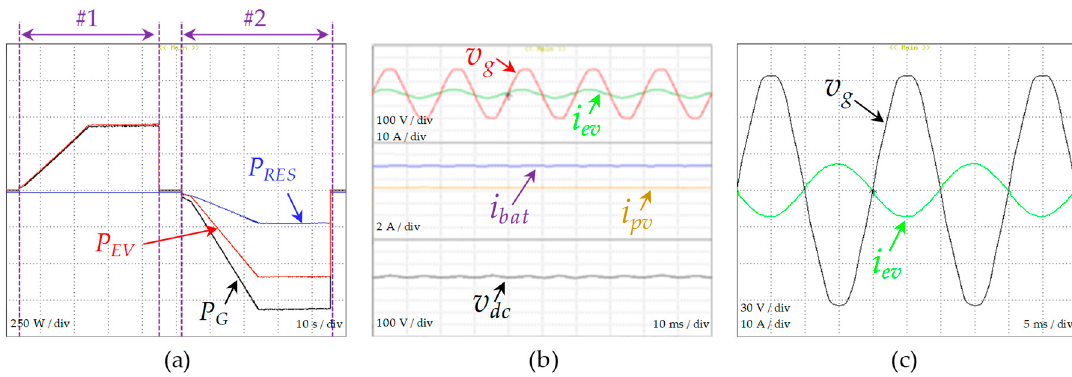
Figure 23. Experimental results of the off-board EVBC considering the integration of renewables (photovoltaic panels): ( a ) During 100 s in the grid-to-vehicle (G2V) and vehicle-to-grid (V2G) operation modes with renewables—power in the grid side (P G ), power in the EV side (P EV ) and power in the RES side (P RES ); ( b ) during 100 ms in the G2V mode-grid-side current (i ev ) and voltage (v g ), dc-link voltage (v dc ), EV battery current (i bat ), and photovoltaic panels current (i pv ); ( c ) during 50 ms in the V2G mode-grid-side current (i ev ) and voltage (v g